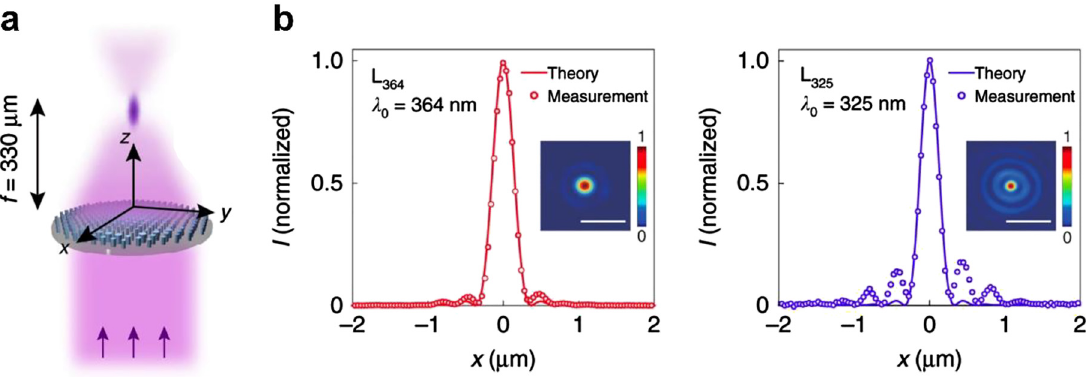
Figure 8: (a) Schematic drawing of focusing by a UV metalens, L 364 or L 325 , under normal-incidence, plane-wave illumination at free-space wavelength of λ 0 = 364 or 325 nm, respectively. (b and c) Cross-focus cuts and intensity distributions in the focal plane, as measured for metalenses L 364 and L 325 , respectively. The theoretically predicted cross-focus cuts are plotted for reference. Scale bars: 1 µm. Zhang et al. [106]. Author